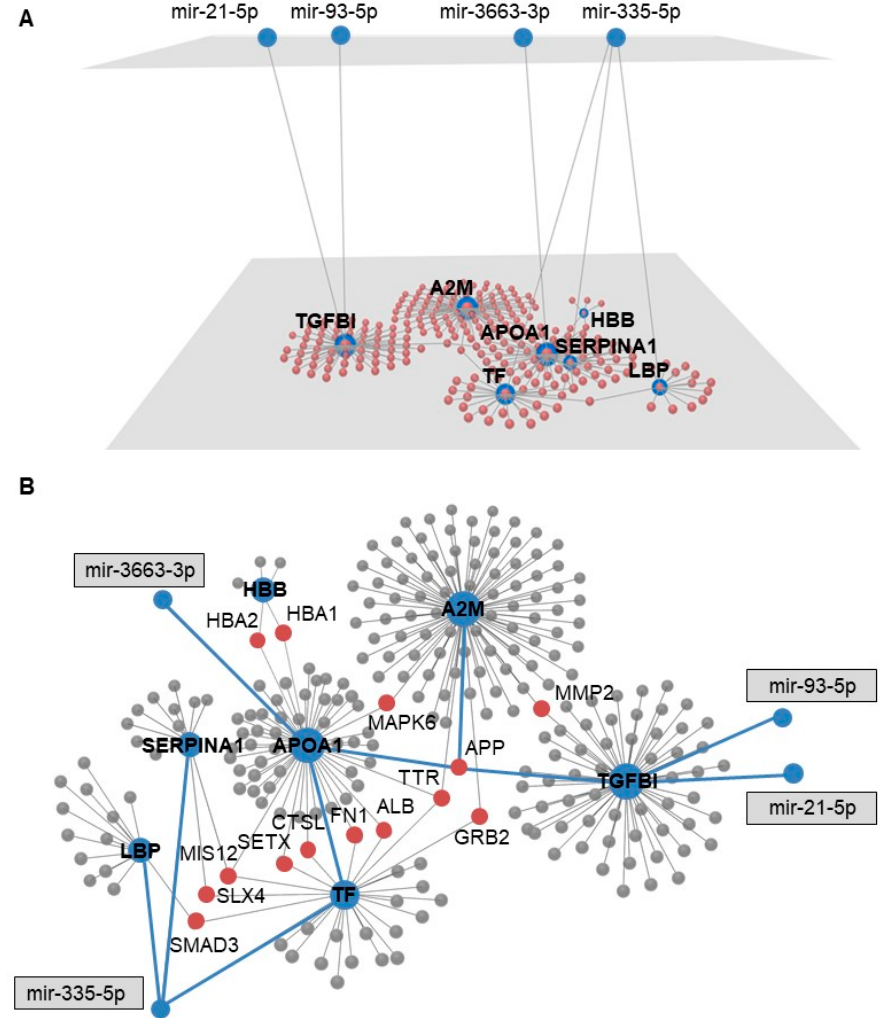
Figure 2. Three-dimensional (3D) multi-omics layered network in CAVD. ( A ) 3D multi-omics layered network containing differentially expressed miRNAs (upper layer) and overlapping molecules between transcriptome and proteome (lower layer). Blue nodes represent input molecules. Red nodes are based on protein–protein interactions (PPI). ( B ) Relevant PPI from A. Blue nodes: input molecules/miRNAs. Red nodes: connector molecules to at least two input molecules. Gray nodes: connector molecules. Blue line: network connecting the input molecules/miRNAs. The integration of tissue-originated or plasma-originated proteins with the differential miRNAs maintained the connector molecules (including APP and TTR) and over-represented pathways (Supplementary Figure S7, Tables S18–S21).